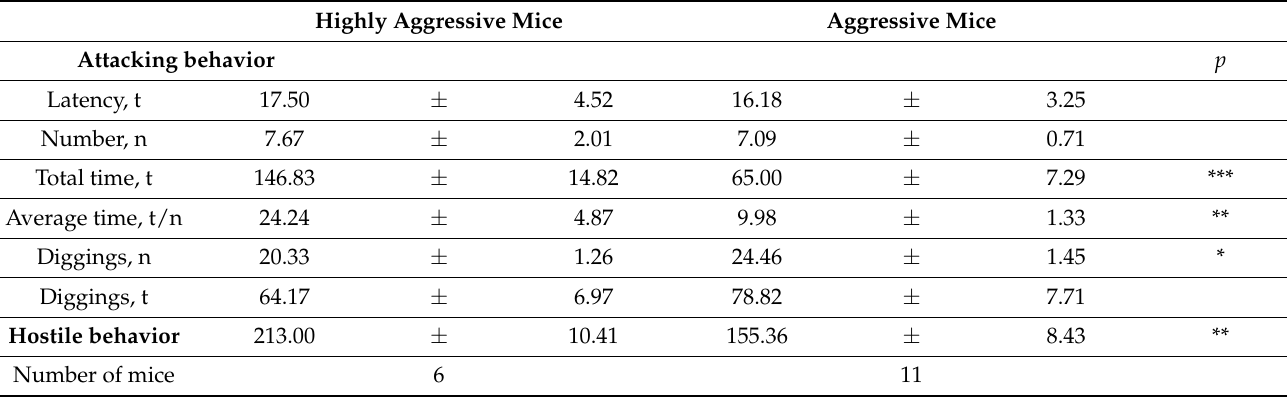
Table 1. Agonistic behavior of mice with different levels of